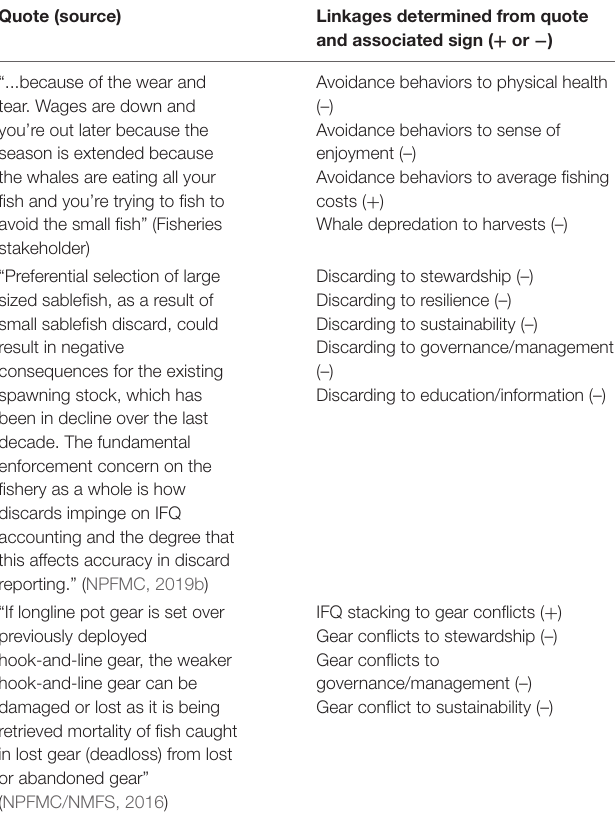
and associated sign ( + or − ) Avoidance behaviors to physical health